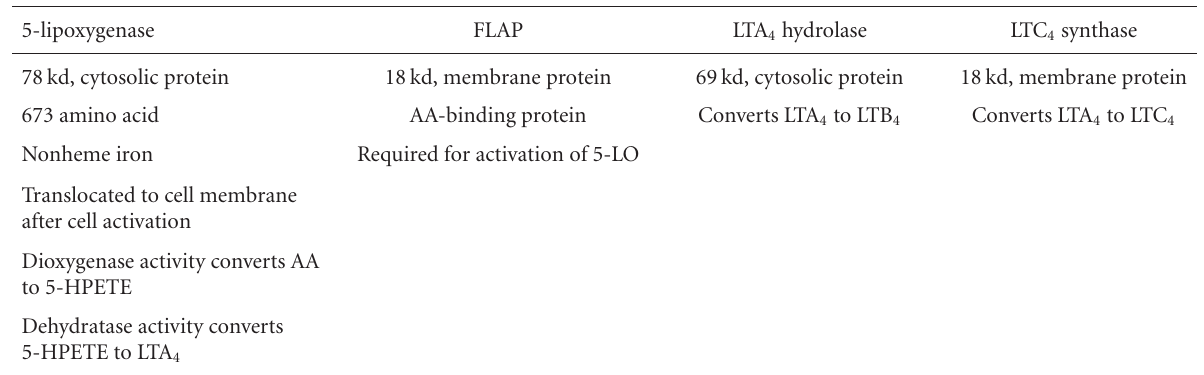
Table 1. 5-lipoxygenase pathway